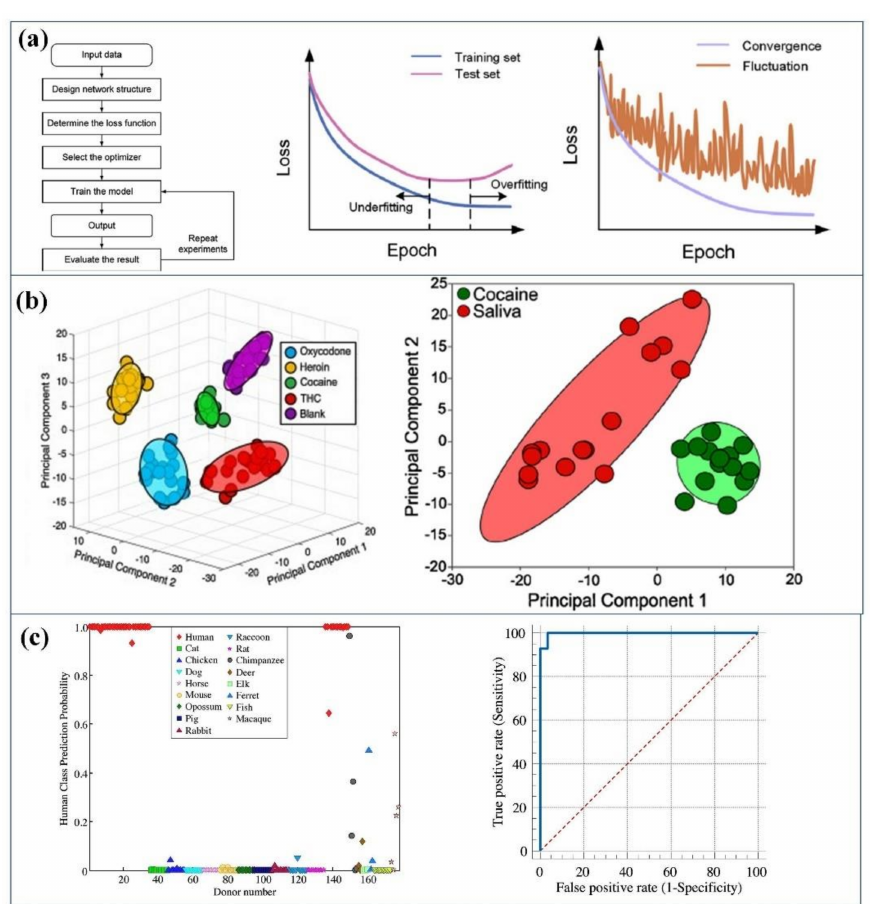
Figure 11. ( a ) Workflow and the scenarios of overfitting and underfitting. Reproduced from Ref- erence [137] with permission. Copyright 2019, Elsevier; ( b ) results of two combined models, i.e., Principal Component Analysis and Support Vector Machine which can be used to distinguish cocaine, oxycodone, tetrahydrocannabinol, and heroin. Reproduced from Reference [139] with permission. Copyright 2018, Elsevier; ( c ) the prediction of partial least squares discriminant analysis (PLS-DA) model for all external human blood donor samples. Reproduced from Reference [140] with permis- sion. Copyright 2018,